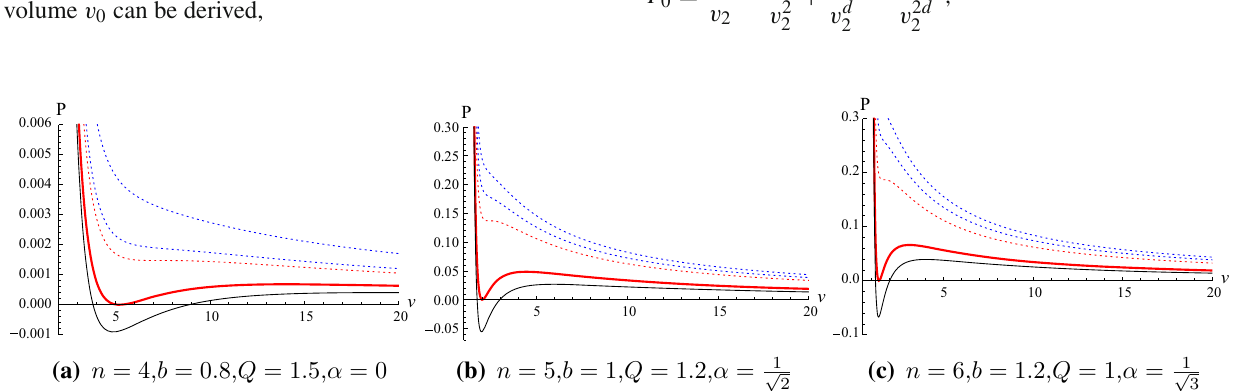
Fig. 1 Isotherms in the P – v diagrams of higher-dimensional charged topological dilaton black holes in n dimensional AdS